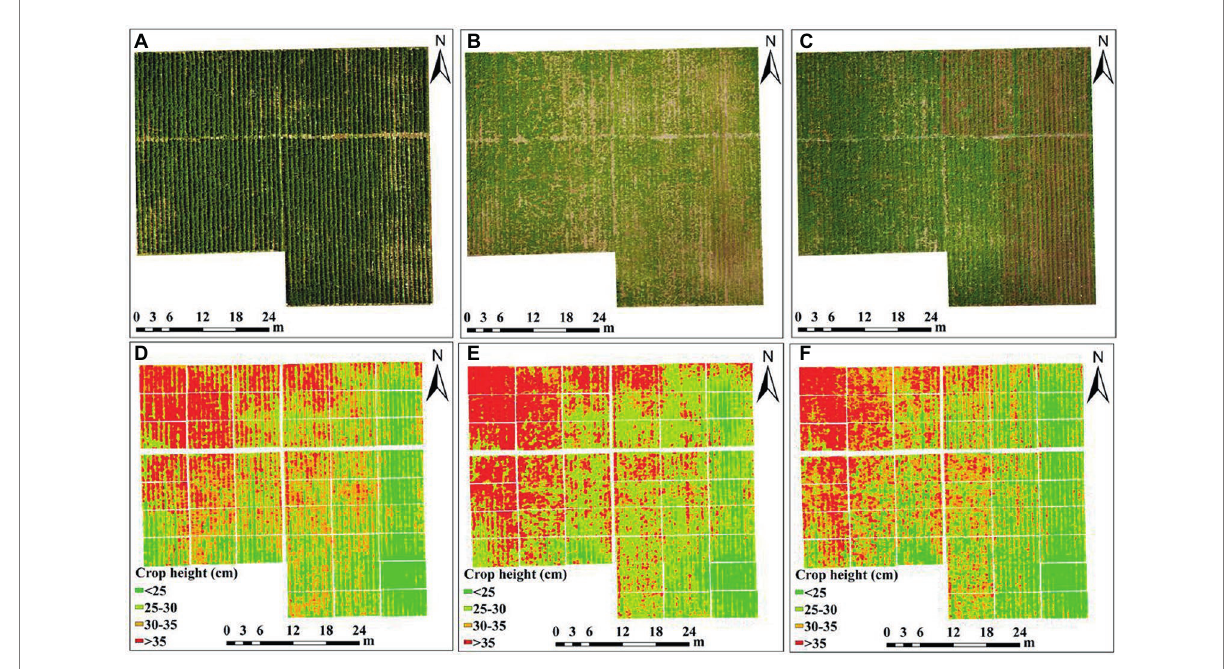
FIGURE 2 UAV RGB images and potato crop height of each plot. (A,D) P1, (B,E) P2, and (C,F) P3